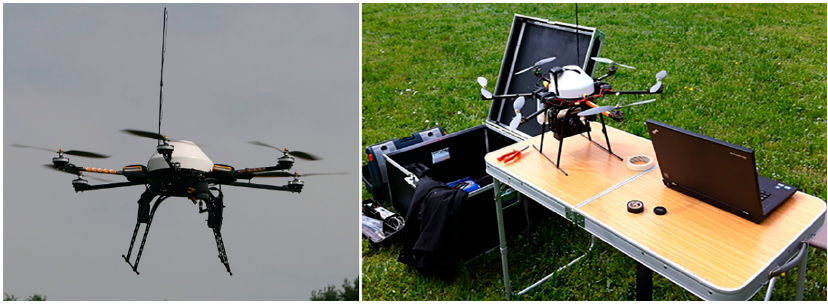
Figure 2. PoliMi HexaKopter with the Ground Control Station.